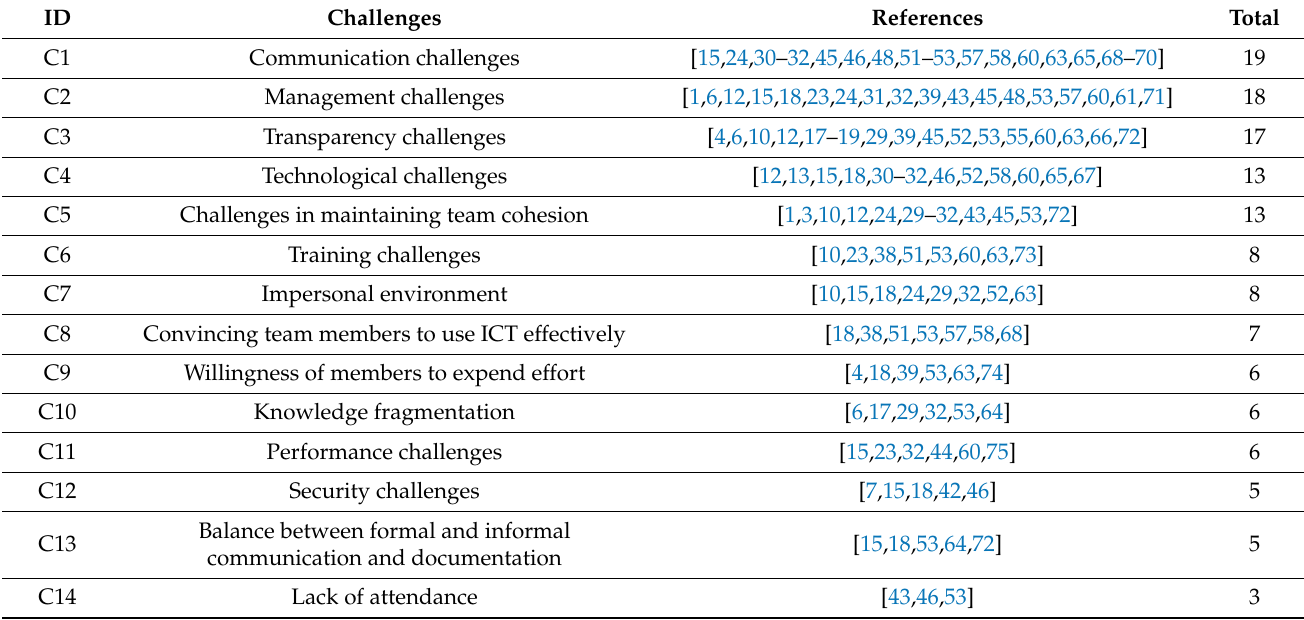
Table 5. RW Challenges elicited from the performed